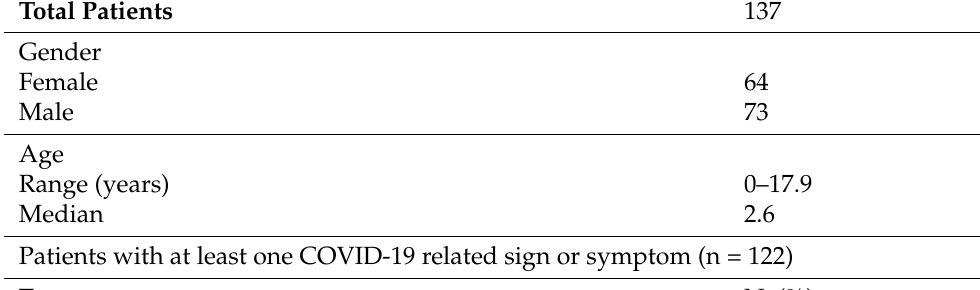
Table 1. Main clinical signs or symptoms of children admitted at the “Giovanni XXIII” Children Hospital of Bari between January 2020 and August 2021 and diagnosed with